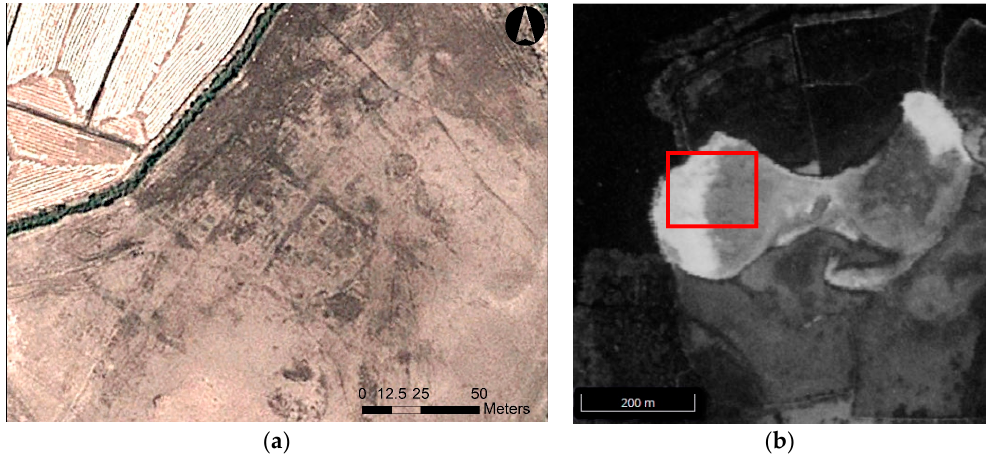
Figure 19. ( a ) The site of Tell el-Damalun. Image courtesy Google Earth; ( b ) 1968 CORONA image. The area of image ( a ) is within the red box. Image courtesy of the Center for Advanced Spatial Technologies, University of Arkansas/U.S. Geological Survey.